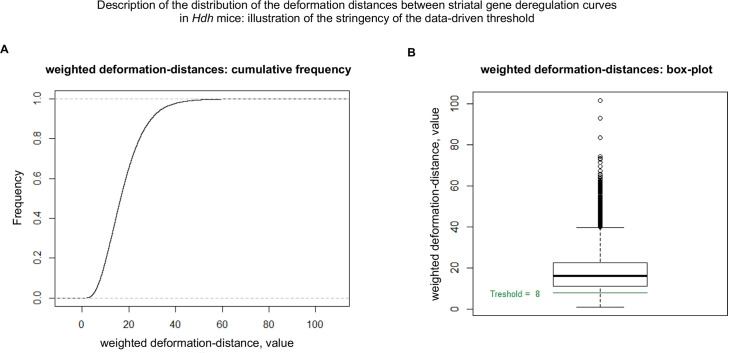
Cumulative distribution of the deformation distances between gene deregulation curves in the striatum of Hdh model mice.This figure shows that the data-driven threshold (see Materials and methods) used for matching the whole-striatum gene deregulation curves to the cell-type-specific curves, that is, a threshold value of 8, is rather stringent. (A) Cumulative distribution of the deformation distances. (B) Box plot for the deformation distances.